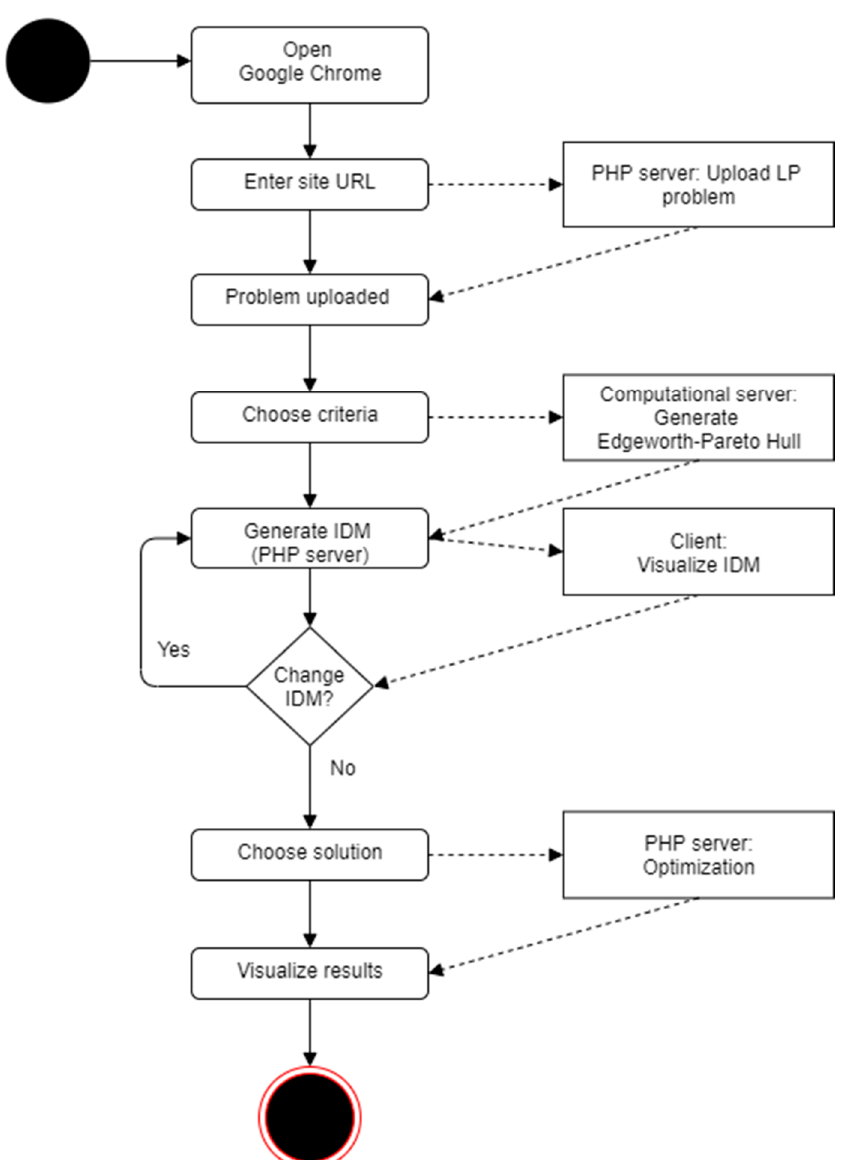
Figure 4. Decision tool’s flowchart.